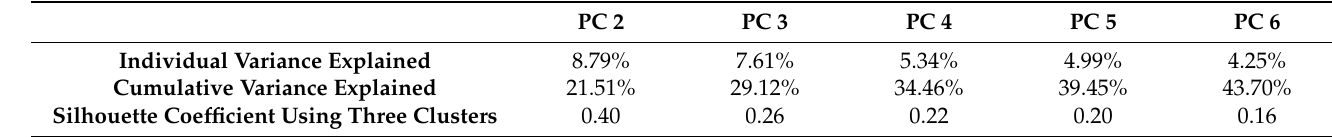
Table 2. Same as Table 1, but for Lake